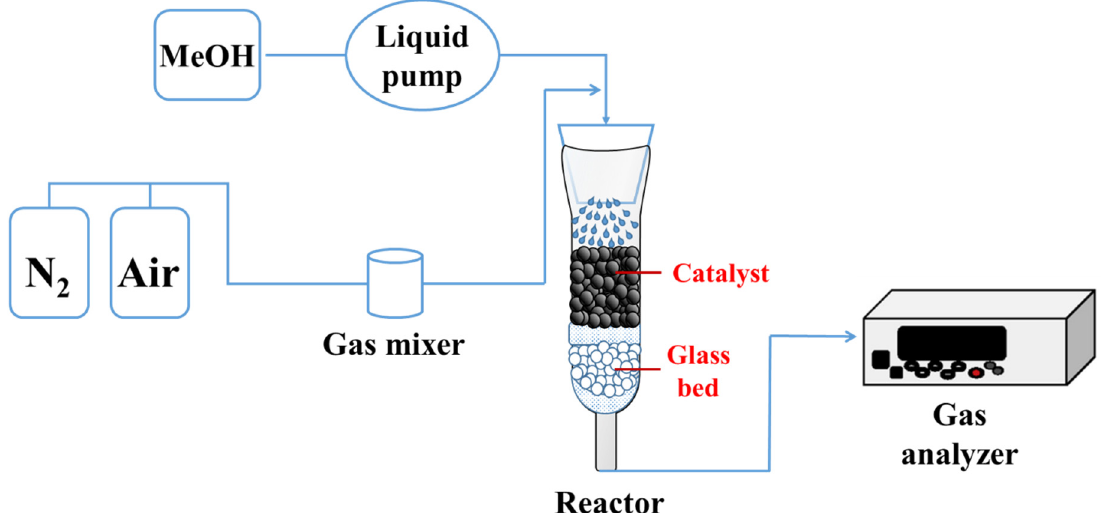
Figure 7. Schematic illustration of POM arrangement.